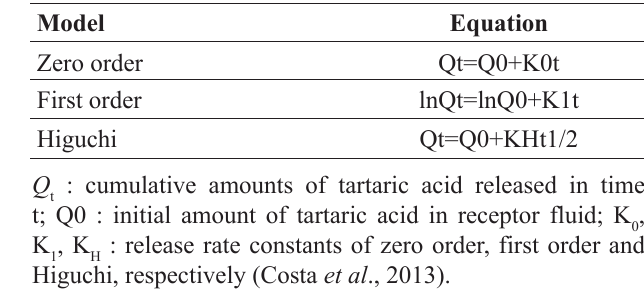
TABLE II - Kinetics of drug release